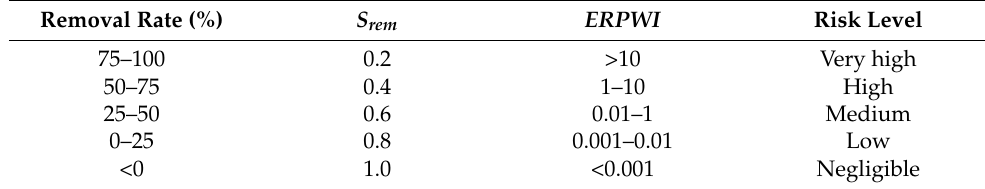
Table 4. Removal scores and ERPWI classification.